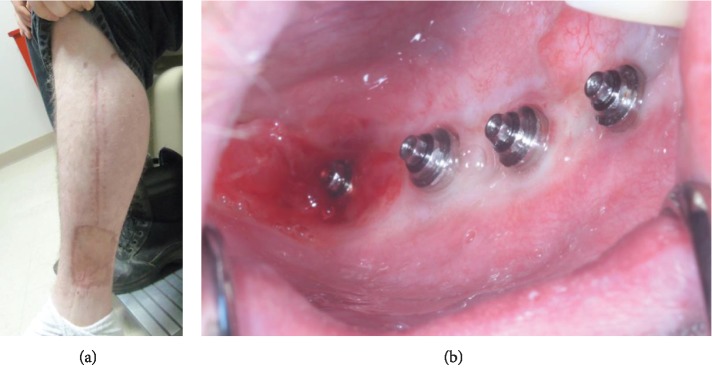
Six-month postoperative photos. (a) Lower extremity donor site. (b) Intraoral photo with prosthesis removed.